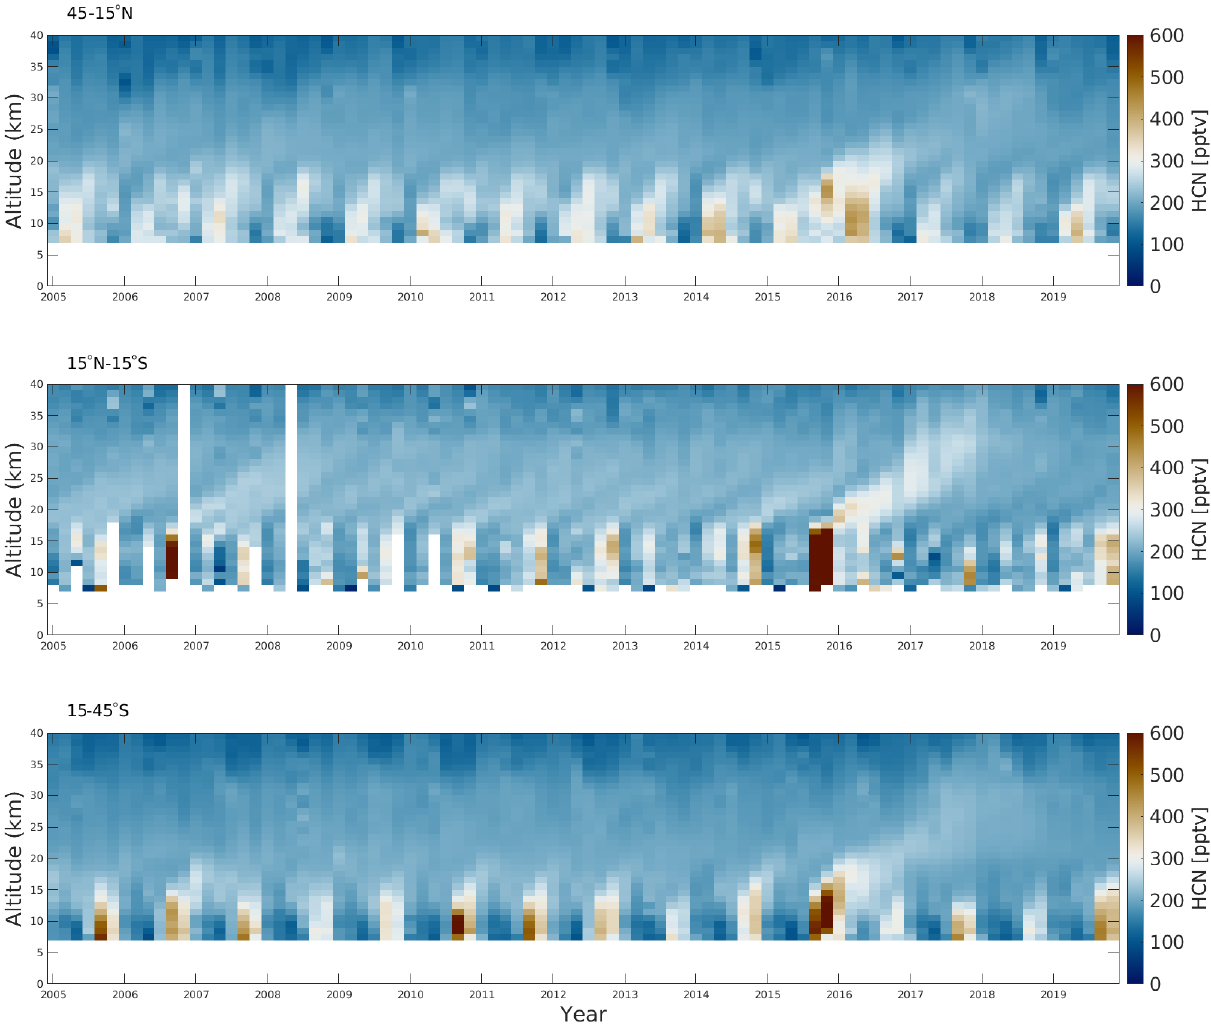
Figure 2. Time–altitude sections of 2-month mean HCN mixing ratios (pptv) from ACE-FTS averaged into three 30 ◦ latitude bins, 45– 15 ◦ N, 15 ◦ N–15 ◦ S, and 15–45 ◦ S, for 2005–2020. Note that the colour scale saturates and the maximum observed HCN mixing ratio in the tropical band in 2015 is over 1300pptv.